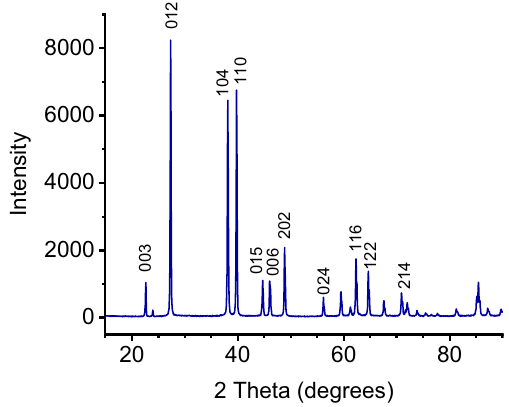
Figure 6. XRD of a polished 24-h pulse-plated Bi coating.